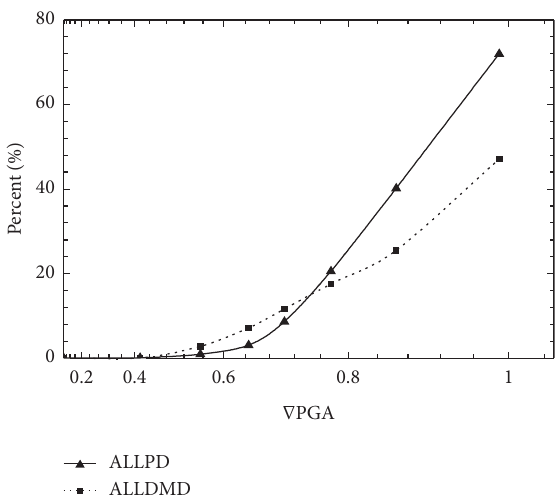
Figure 12: Dissipated energy growth